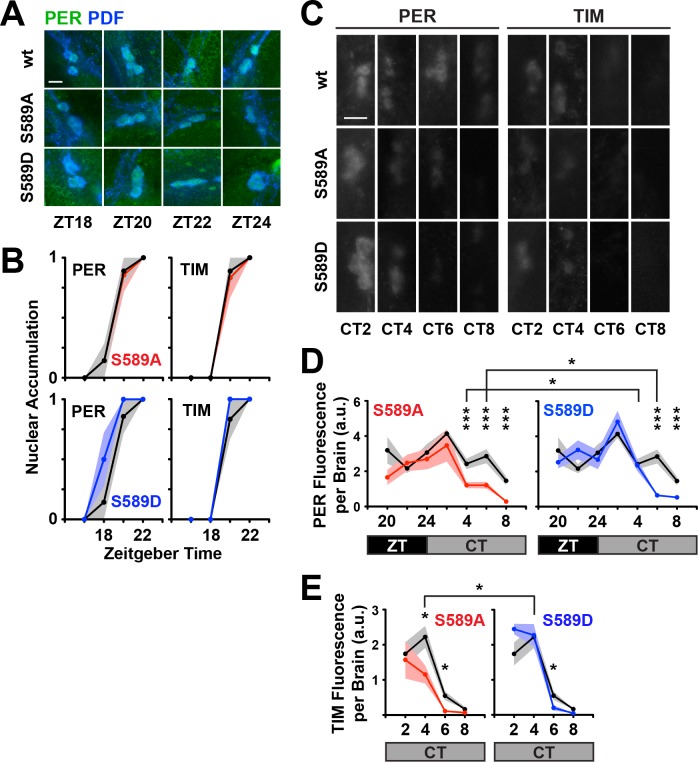
Residue substitutions of S589 do not affect nuclear entry, advance PER degradation in small ventral lateral neurons in vivo.(A) Fly brains were collected at the indicated zeitgeber time points (ZT) and fixed. Representative images of s-LNvs stained for PER (green) and PDF (blue) are shown. The scale bar represents 5 μm. (B) Stained fly brains were visually scored to determine PER/TIM nuclear accumulation. PER or TIM staining that is predominantly nuclear or cytoplasmic in the small LNvs were valued 1 or 0, respectively. Six to ten fly brains were averaged for each mutant (S589A, red line; S589D, blue line) at the indicated time points, and compared to wild type control (black line). Each data point represents the mean, ±SEM. Thickness of the curve reflects SEM. (C) Fly heads were collected at the indicated circadian time points (CT; constant darkness). Representative images of s-LNvs stained for PER and TIM are shown. PDF stain is omitted for clarity of PER/TIM signal intensity. The scale bar represents 5 μm. (D) Stained fly brains were quantified for PER expression in small LNvs. Fluorescence signal from 6 to 10 fly brains were imaged and quantified (arbitrary units, a.u.) for each time point, normalized to an internal standard and the two hemispheres averaged to represent the brain. Mutant PER expression (S589A, red line; S589D, blue line) and wild type PER (black line) was plotted and compared. Times are measured in ZT (black box) or in CT, subjective day (grey box). Each data point represents the mean, ±SEM. Thickness of the curve reflects SEM. Black line compares the S589A and S589D mutants. *p<0.05. ***p<0.005. Data points with no asterisks are not statistically significant. Significance was measured by t-test. (E) Stained fly brains were quantified for TIM fluorescence signal as described in panel D. Each data point represents the mean, ±SEM, plotted across CT. Thickness of the curve reflects SEM. Black line compares the S589A and S589D mutants. *p<0.05. Significance was measured by t-test.